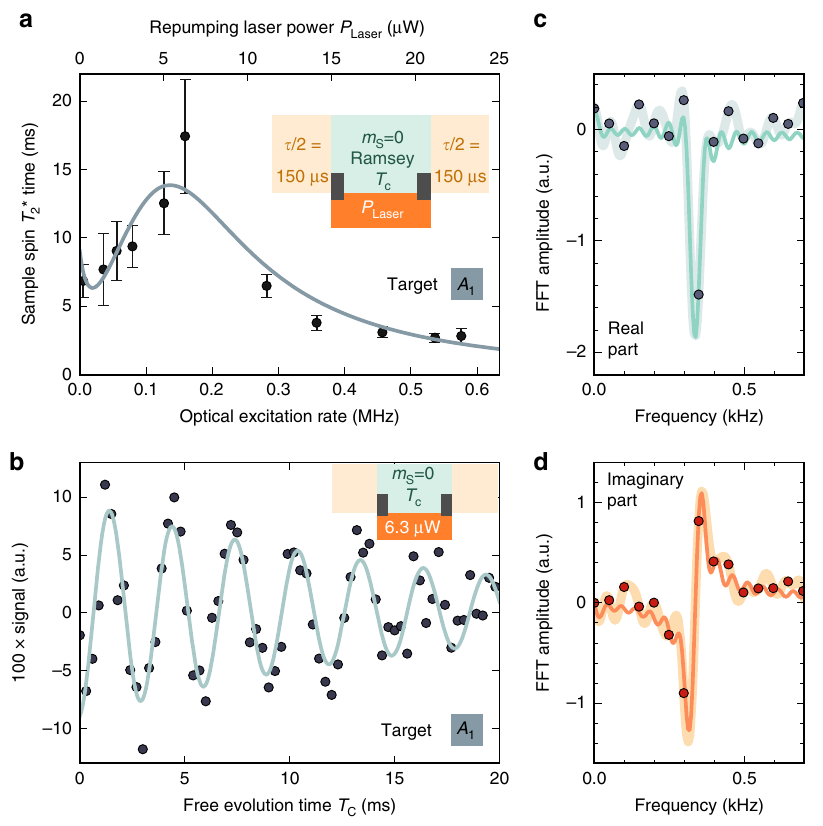
Fig. 3 Dissipative decoupling of target spins during classical storage on quantum memory. a During storage (green background) the sensor-spin fl ips stochastically into a magnetic state ± 1 j i and an orange repumping Laser (594 nm) excites the NV and repolarizes the sensor spin predominantly into the non-magnetic state 0 j i . We perform Ramsey measurements on target spin A 1 and record the T (cid:2) time depending on the applied optical excitation rate. The 2 shown errors correspond to the standard error of the exponential fi t to the decay of the spin state. We fi tted simulated coherence lifetimes to the measured results using three parameters, (i) the conversion from applied laser power to excitation rate, (ii) the ionization probability, and (iii) the probability for the ± 1 j i excited state to decay via the metastable state into the 0 j i ground state (see “ Methods ” ). Three distinct regions are observed. The fi rst decrease